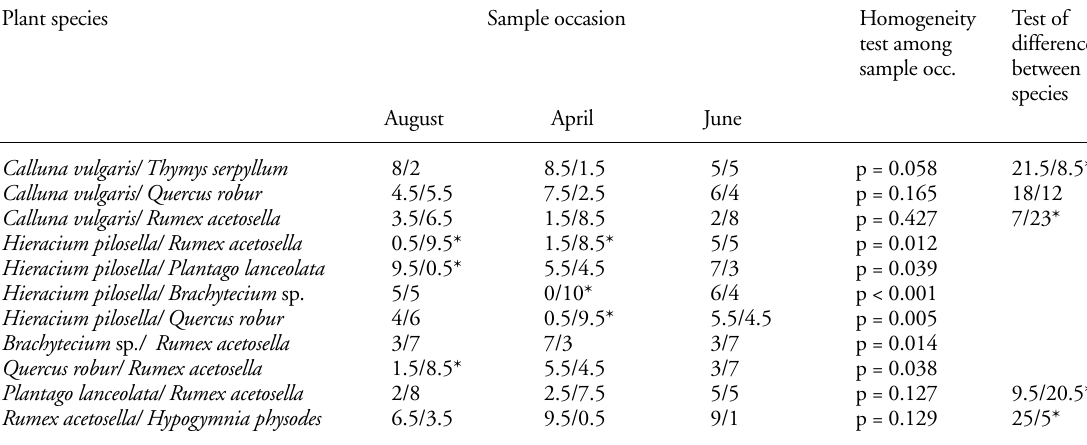
Homogeneity among the three occasions was tested for each trial. Data in homogeneous trials was pooled for the test of difference between species. In heterogeneous trials test of difference between species for each occasion was tested separately. Significant differences in preference between species ( χ 2 contingency table, p < 0.05) are denoted by *